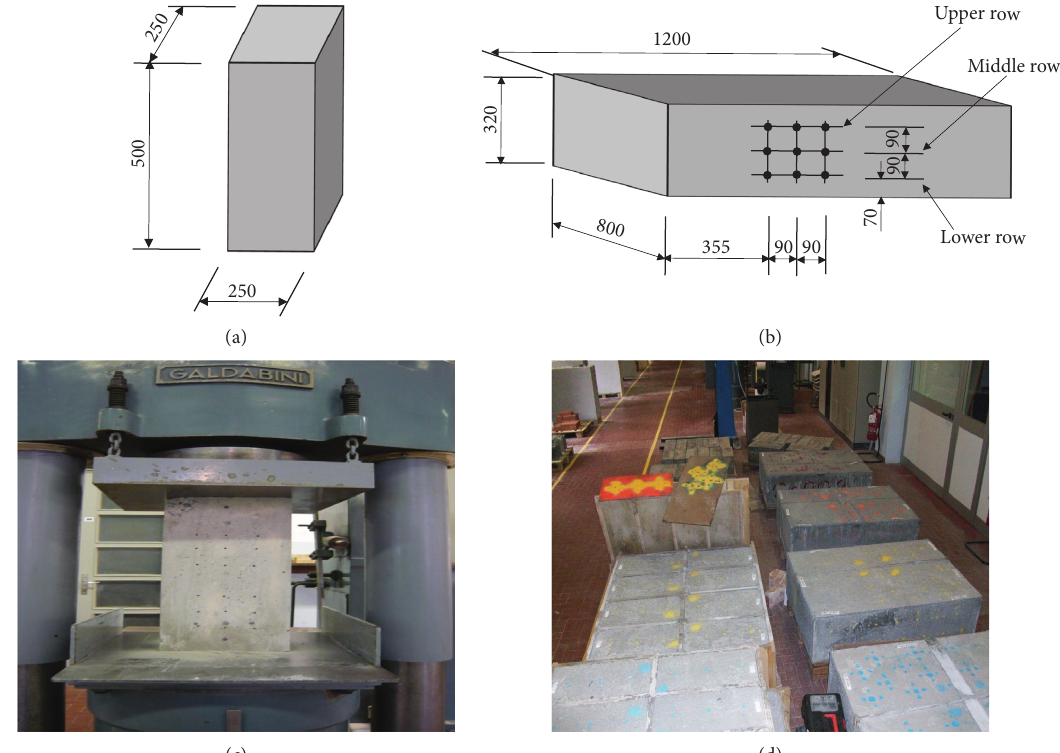
Figure 3: Specimens used for calibration. Geometry of (a) the prisms and (b) the large prisms; crosses indicate the locations of the tests; (c) prism inside the press to preload the specimen; (d) large prism in the laboratory.